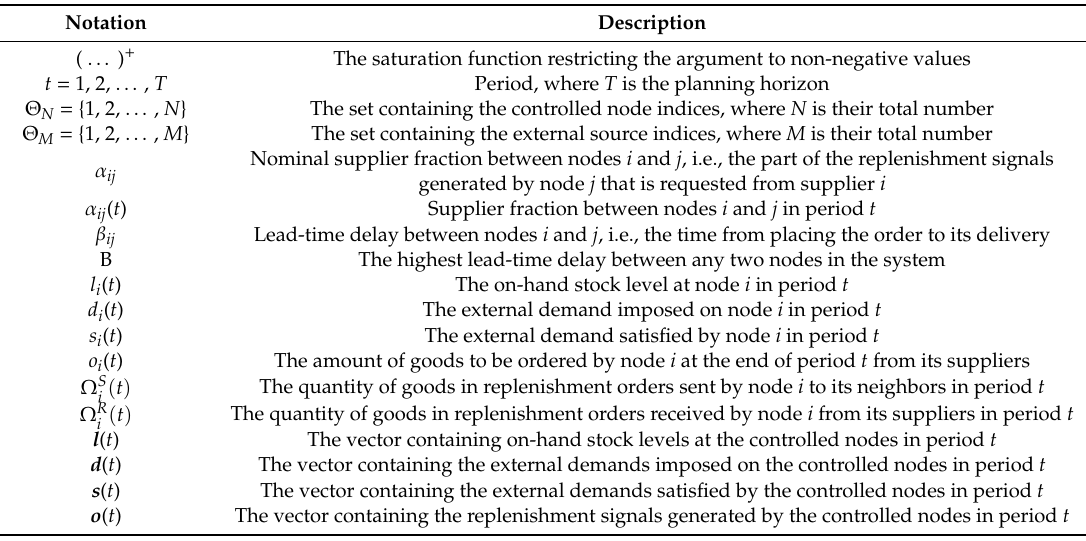
Table 1. Mathematical